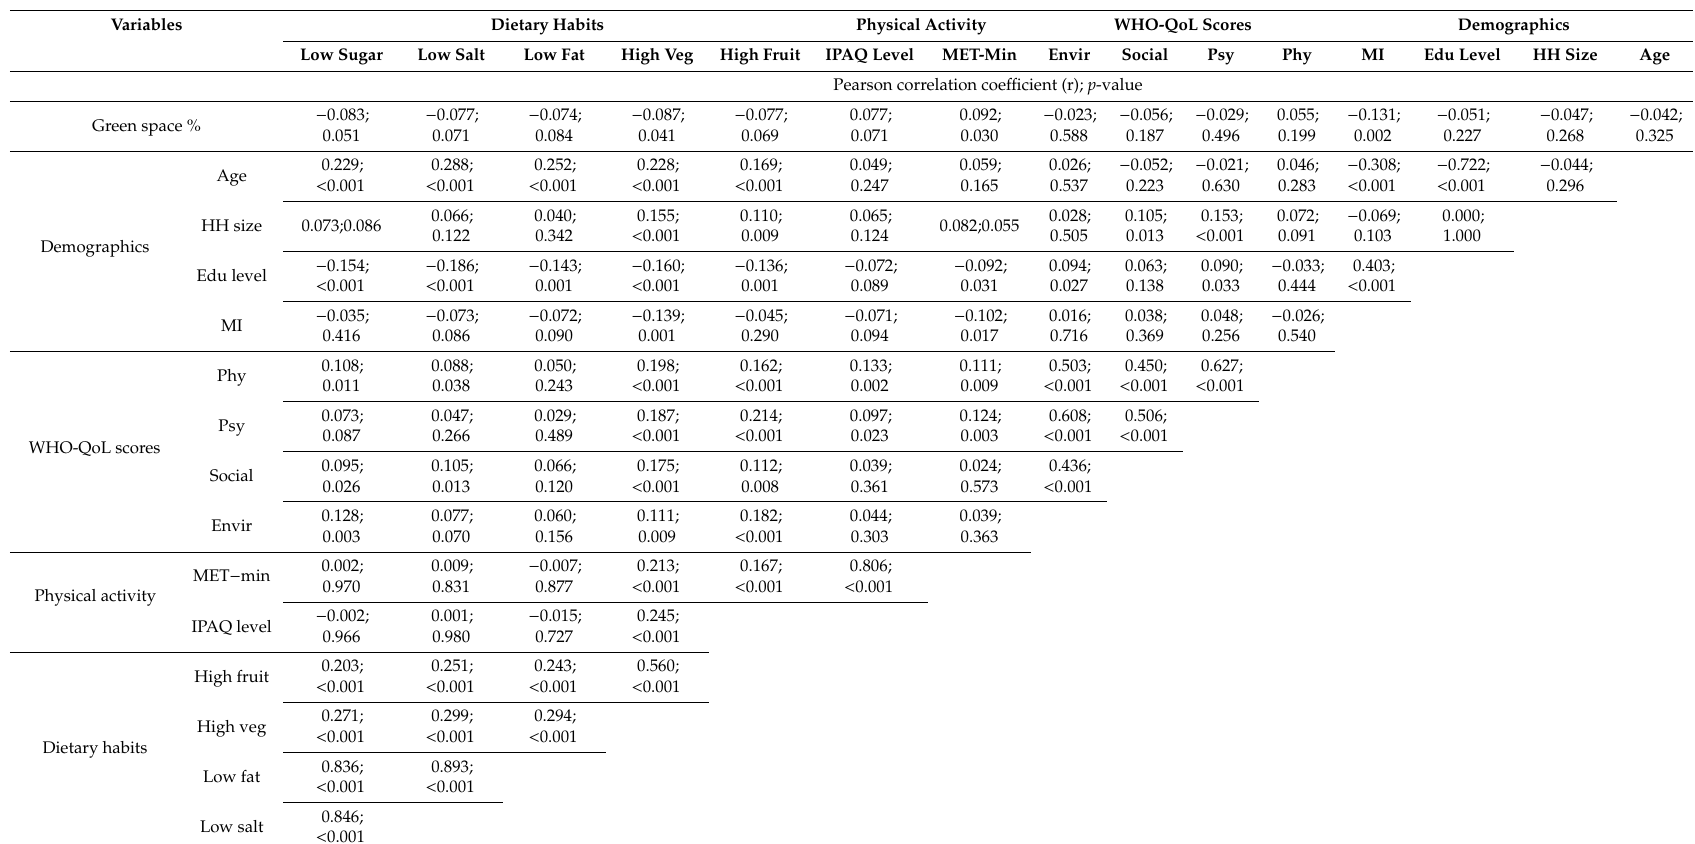
Table 3. Correlational analysis among variables measured in the studied